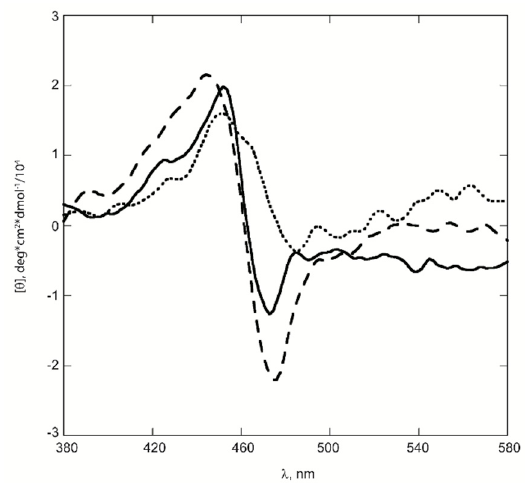
Figure 3. CD spectra of porphyrins 1 and 2 (3.7 µ M) in aggregative conditions. (Solid line) 1 in H 2 O / CH 3 CN 50:50; (dashed line) 2 in H 2 O / CH 3 CN 55:45; (dotted line) 2 in H 2 O / CH 3 CN 55:45, NaBr 0.010 M. Adapted with permission from [34]. Copyright 2007, The royal Society of